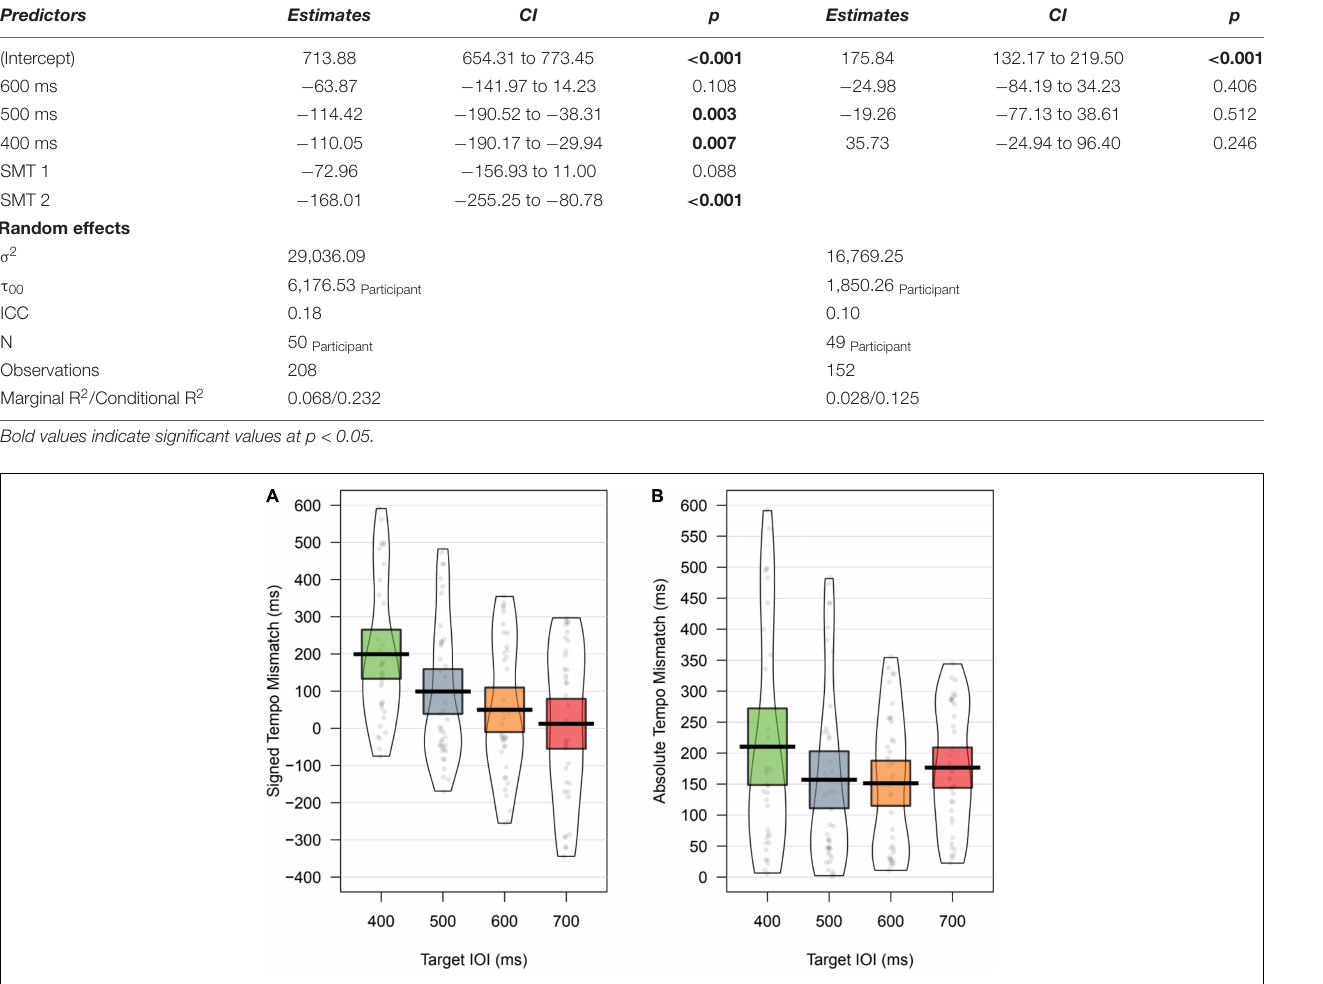
FIGURE 5 | Panel (A) depicts the tempo mismatch of infant drumming (IOI of drumming – Target IOI). Positive numbers reflect drumming slower than target, and negative numbers reflect drumming faster than target. Values close to zero reflect accurate drumming. Panel (B) depicts the absolute (non-signed) tempo mismatch. The Mean is signified by a bold line, and the 95% CI is